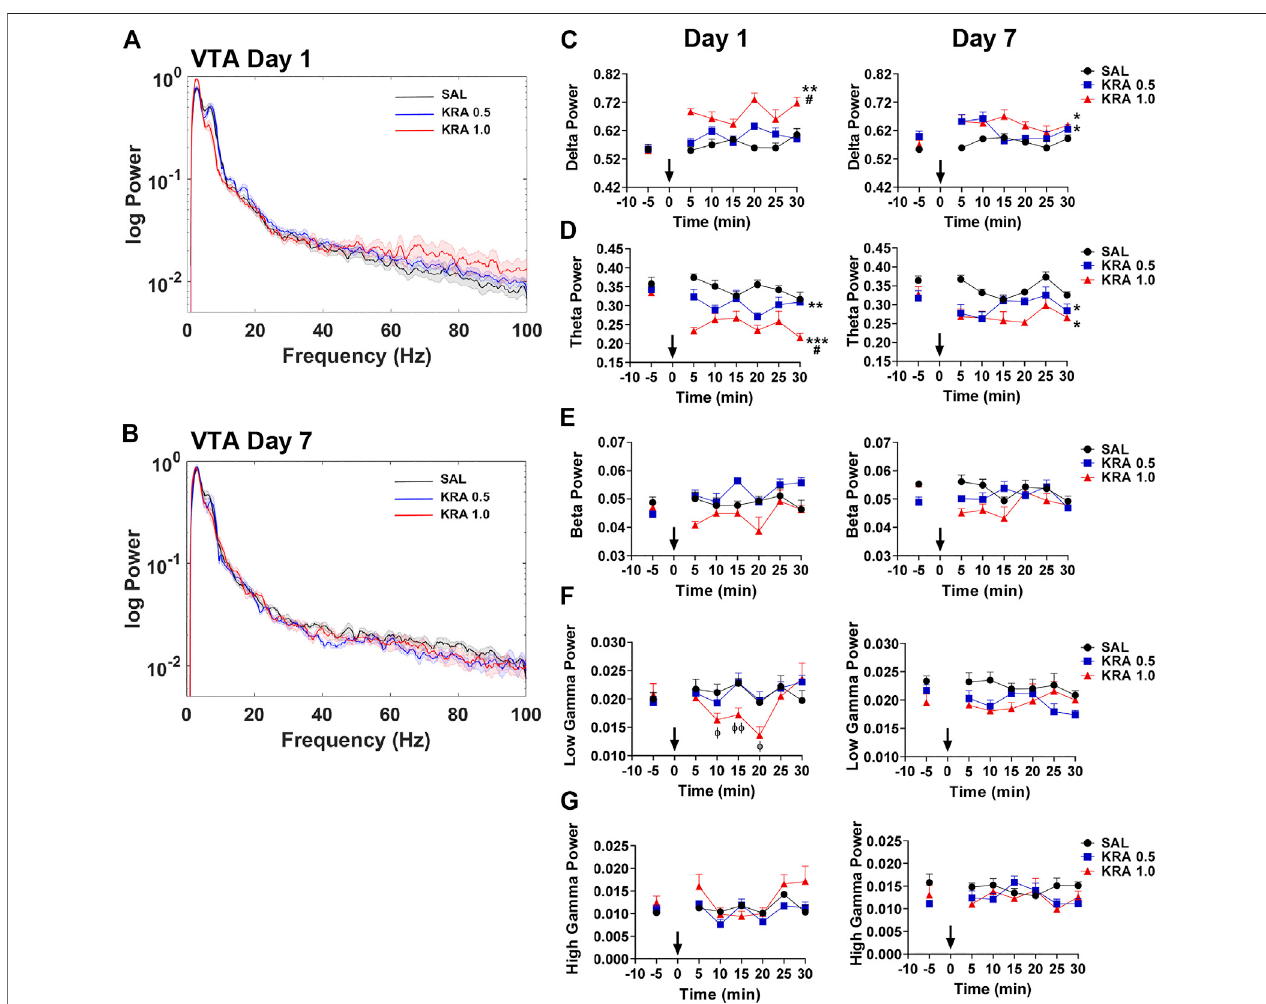
FIGURE 5 | Time course of dose-dependent effects of kratom on VTA spectral power. (A,B) Representative power spectra showing dose-dependent (0, 0.5, 1.0 mg/kg) effects of kratom 30 min post-injection on day 1 and day 7. (C) On day 1, high dose kratom increased delta power whereas on day 7, an elevation in power was induced by both doses of kratom. (D) On both day 1 and day 7, both doses of kratom resulted in a reduction in theta power. (E) No drug-induced changes in beta power were evident. (F) A transient decrease in the low gamma power in response to only high dose kratom on day 1 with no effects on day 7 (G) No effects of kratomtreatmenton high gammapower on day 1or day 7. N (cid:2) 7 – 10rats per group, with2 electrodes/rat. Curves arerepresented asmeans with jackknife estimates of sem depicted by the shaded areas. Bars represent mean ± sem. * p < 0.05, ** p < 0.01, *** p < 0.001 compared to saline control rats. # p < 0.05 compared to low dose kratom treated